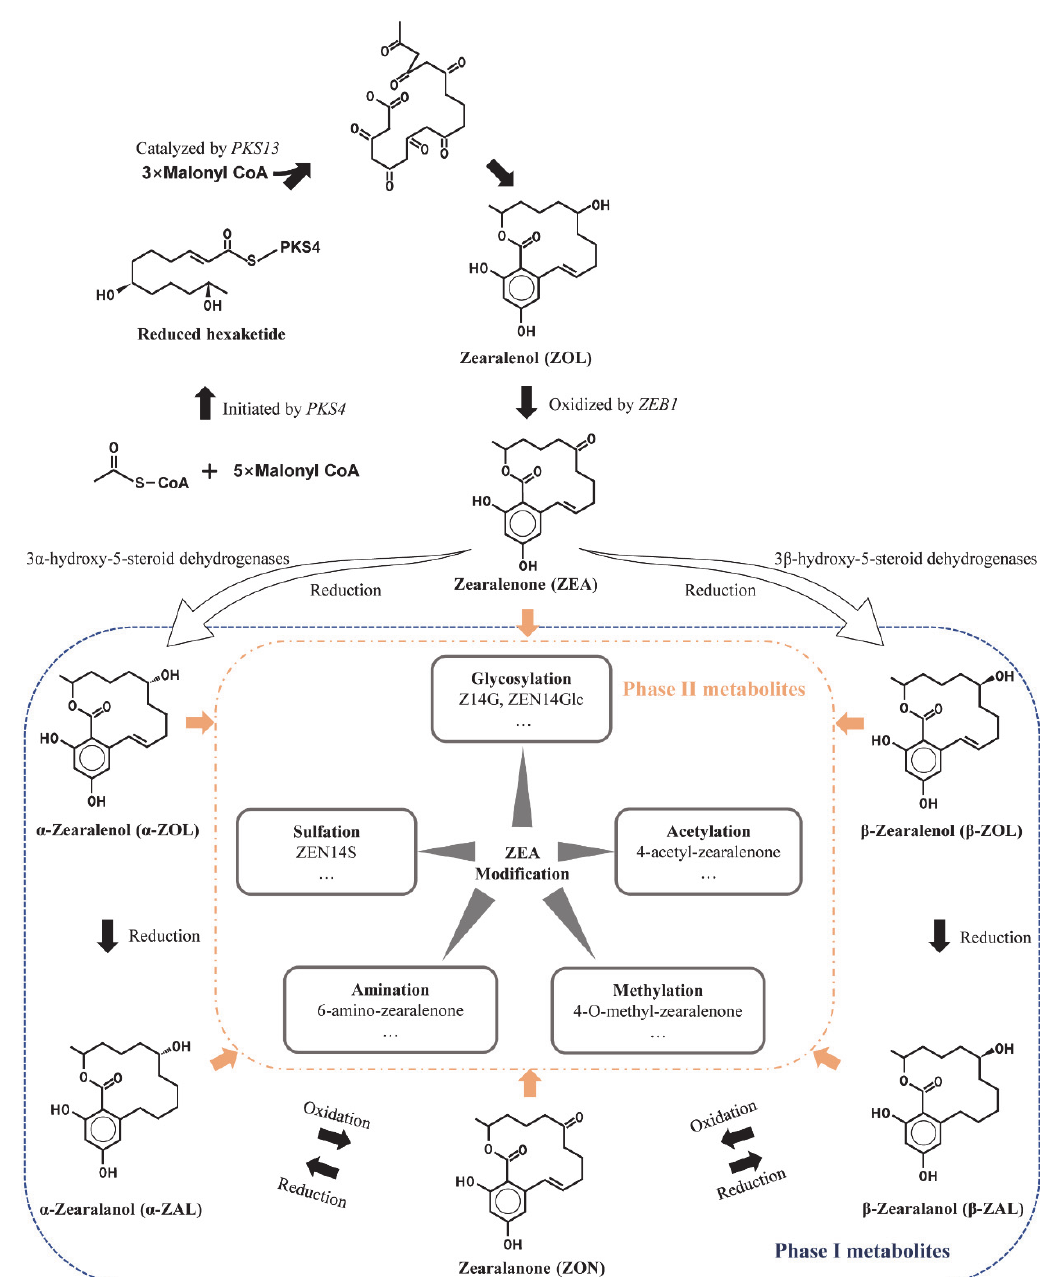
Figure 1. An overview of ZEA and masked ZEA formation.